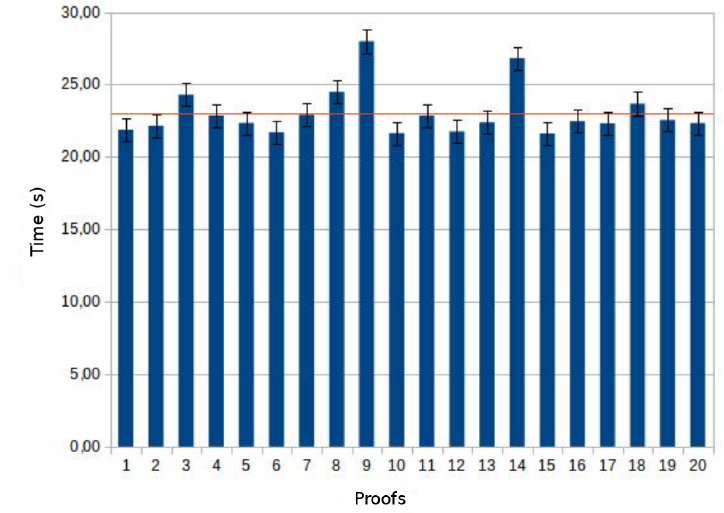
Figure 5. collect action for 500 MB file. 20 proofs average and confidence interval equal to